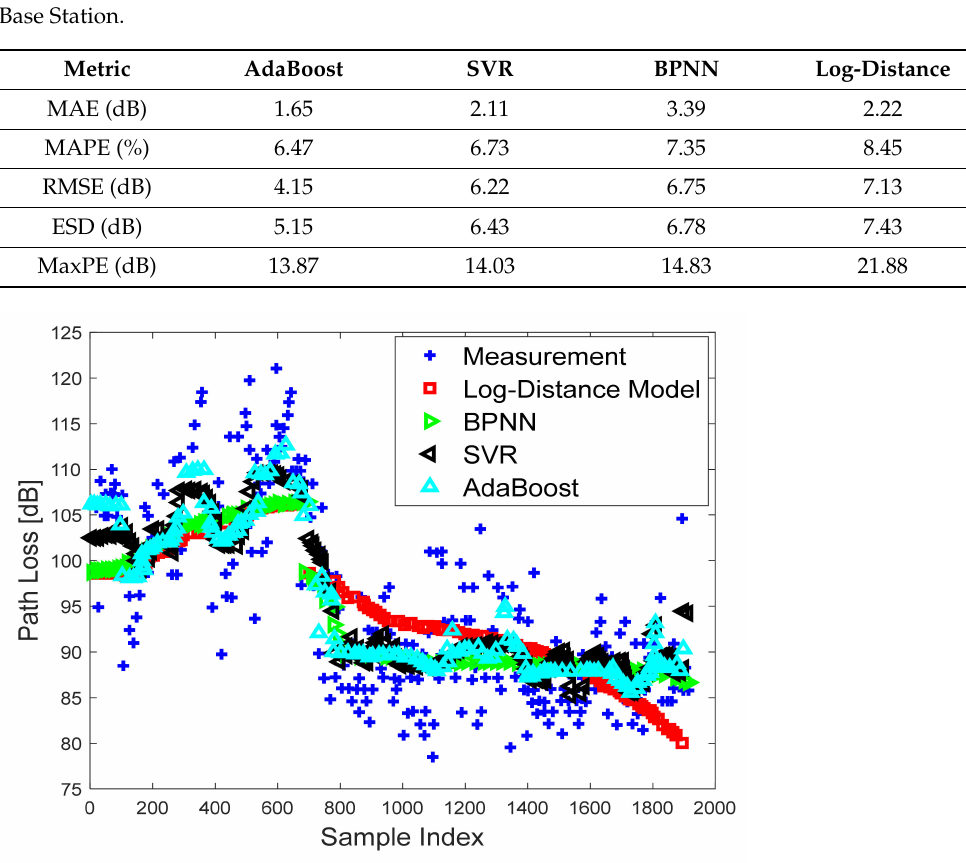
Figure 3. Path loss prediction of various machine-learning algorithms on the test dataset using samples from OSRC base station; 80% of data were used for training while the other 20% for